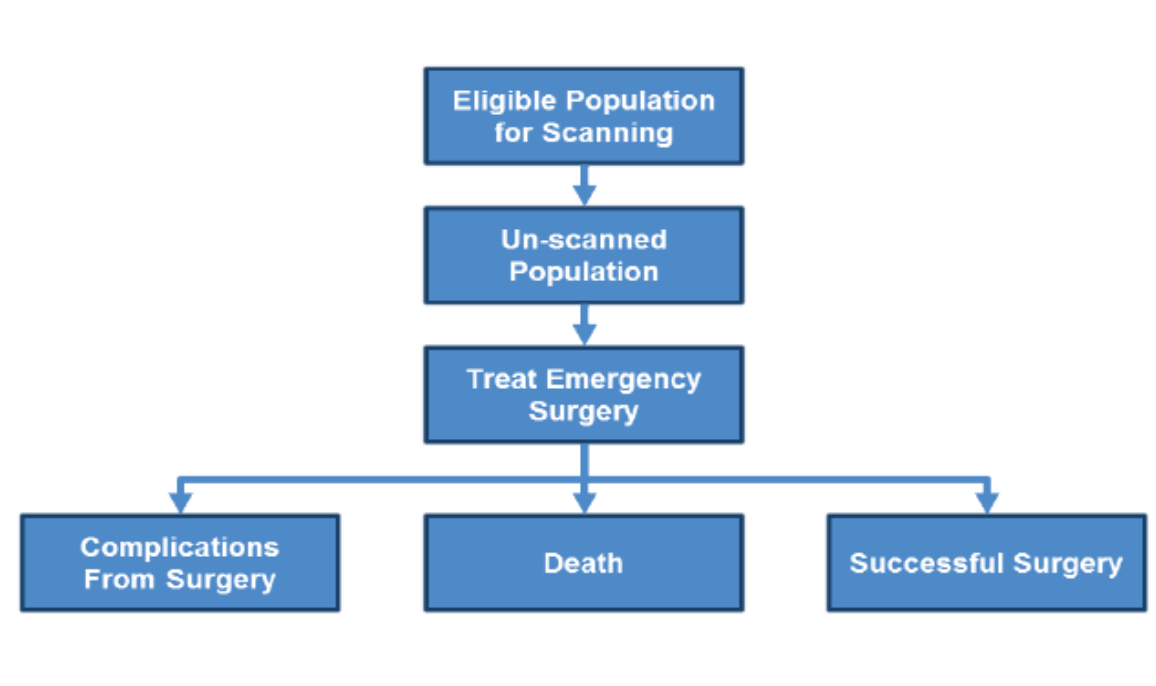
Figure 1. Decision Model Scenario I